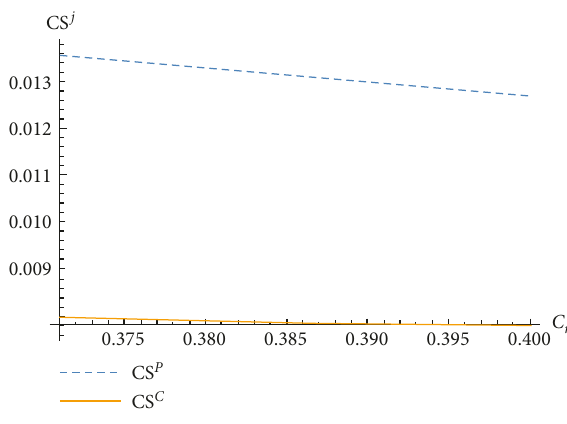
Figure 3: Social outcomes: effects of c